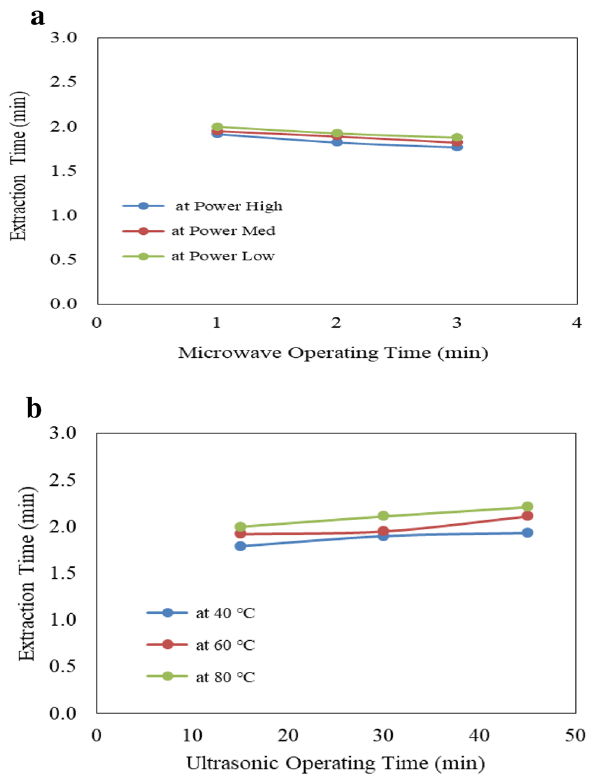
Figure 10. ( a ) Effect of microwave condition on oil extraction time. ( b ) Effect of ultrasonic condition on oil extraction